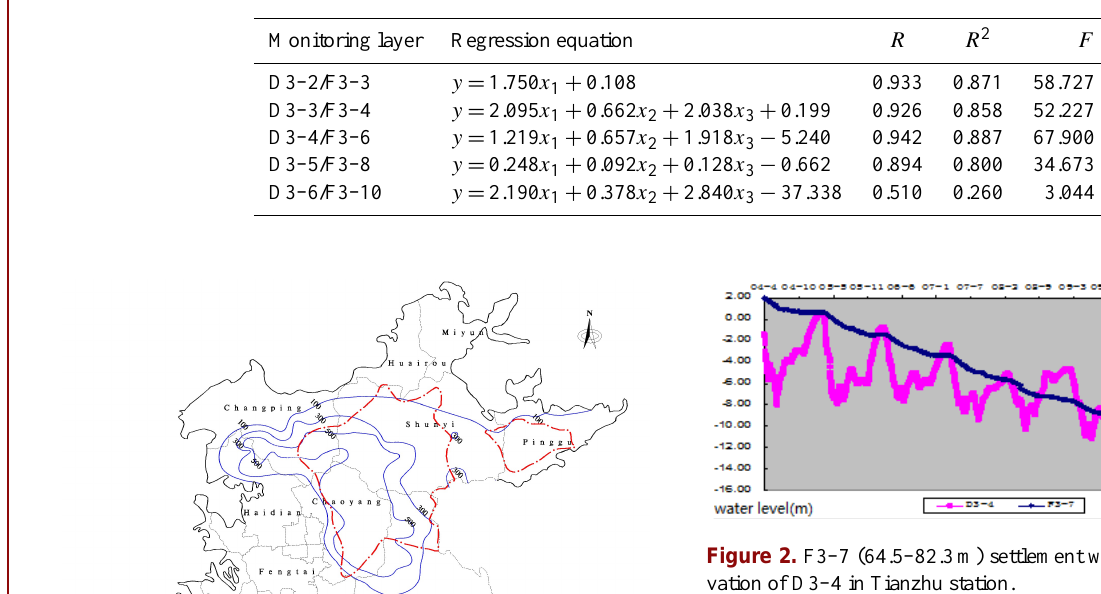
Table 2. Results of multiple regression analysis.